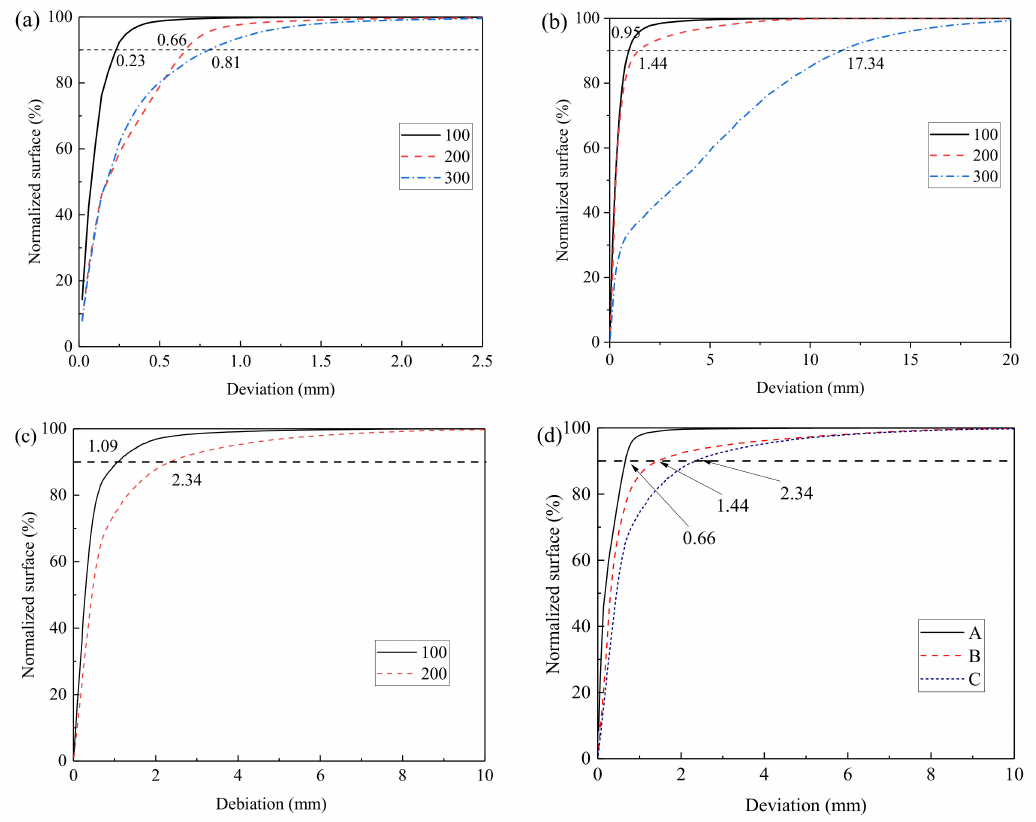
Figure 14. Deviation distributions of different groups: ( a ) Group A; ( b ) Group B; ( c ) Group C; ( d ) deviations of different groups after 200